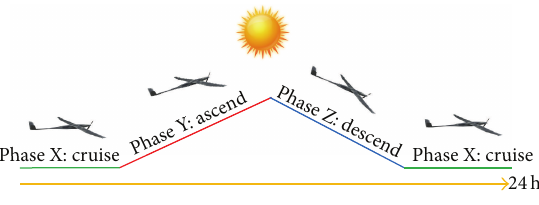
Figure 2: Mission phase.